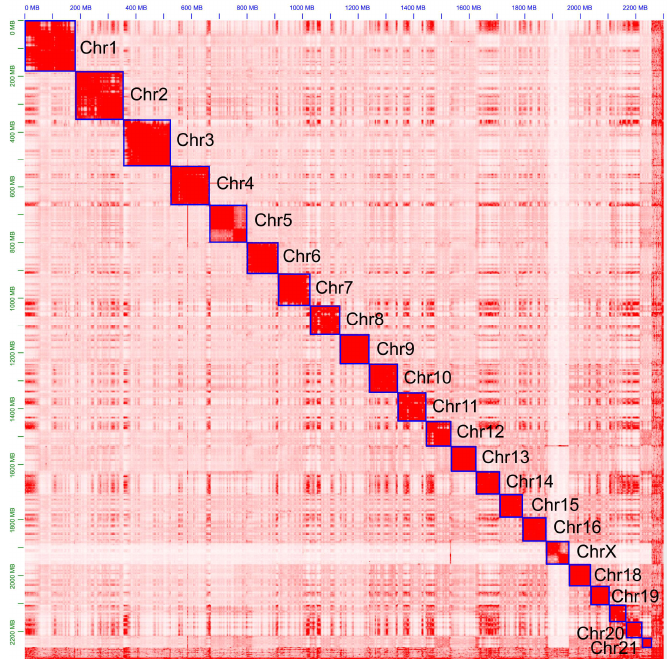
Figure 1. Hi-C heatmap of genomic interactions. Interactions between two locations are depicted by a dark blue pixel.